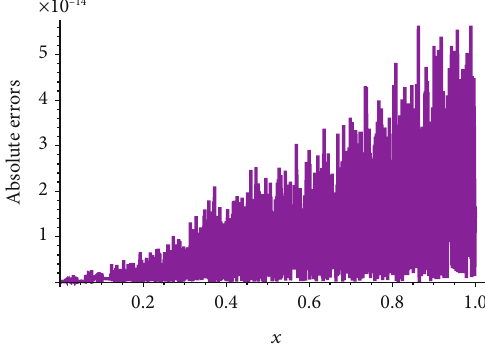
Table 4: The numerical solutions of u